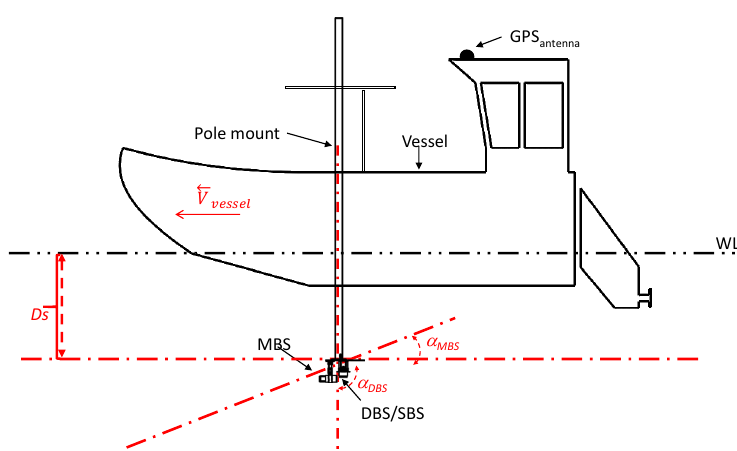
Figure 2. Illustration of a pole mounting system deployed on a vessel. The multibeam sonar (MBS) was deployed at pitch angle of 45°, and the dual-beam sonar (DBS) was at a fixed pitch angle of 90° compared to the water level ( WL ). The survey vessel travelled at a velocity 𝑉 𝑣𝑒𝑠𝑠𝑒𝑙 of 0.2 m s −1 or 2.4 m s − 1 depending on the survey phase. Both sonar systems were deployed at drafts ( Ds ) of 0.5 m. SBS refers to a split-beam sonar.